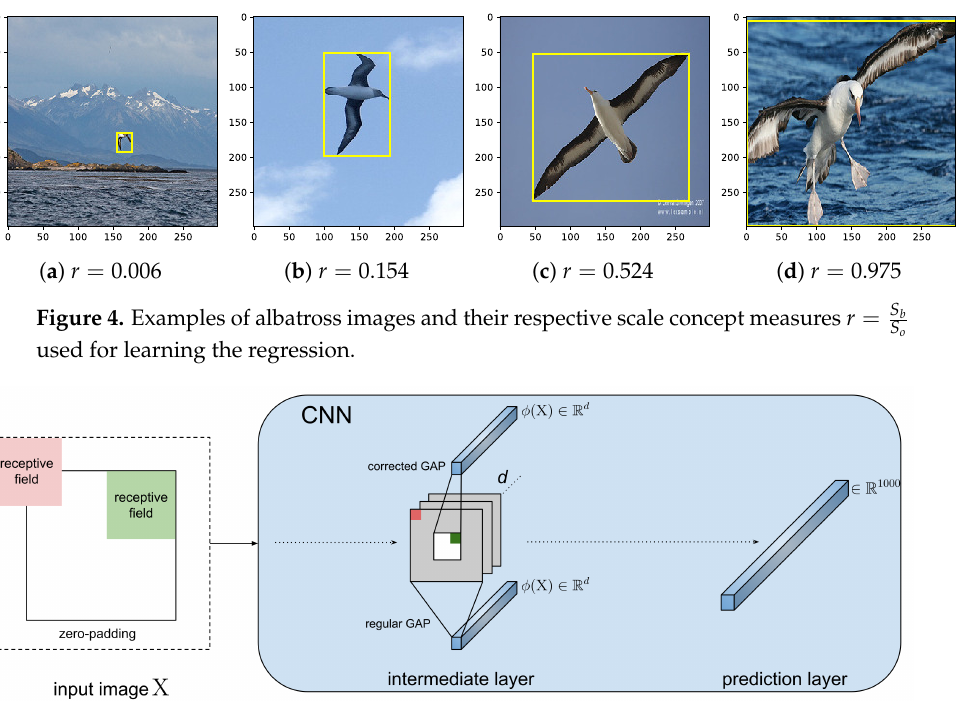
Figure 5. Illustration of the working principle of the corrected Global Average Pooling . The colored receptive fields in the input image ( left ) are associated with the colored neurons in the feature maps ( center ). In the Convolutional Neural Network (CNN), activations used for the corrected GAP ( top ) are displayed in white that is, activations of the neurons with a receptive field contained in the input image. All activations are used for the regular GAP ( bottom ). Best viewed in